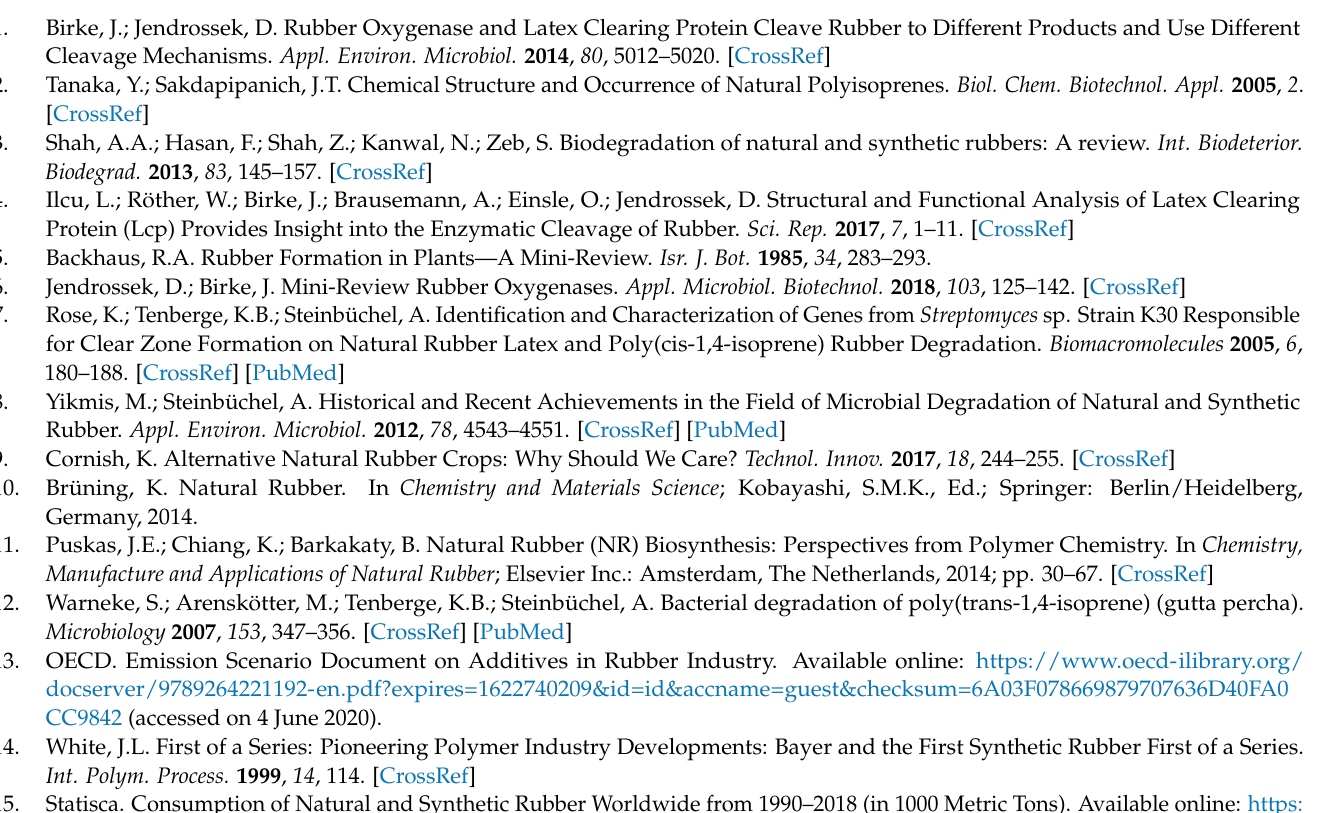
10.3390/polym13121989/s1, Figure S1: Phylogenetic clusters (12) of 248 lcp genes obtained from GenBank, Figure S2: Conserved regions of 248 lcp amino acid sequences from GenBank. Sequences were viewed using Jalview, dark purple shades indicate highest percentage identity among sequences, Table S1: Details of Isolation Source for Actinobacteria containing Lcp Gene in